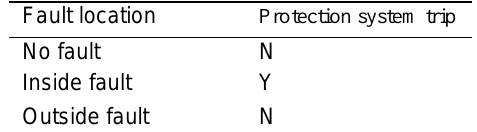
Table 3. Protection result